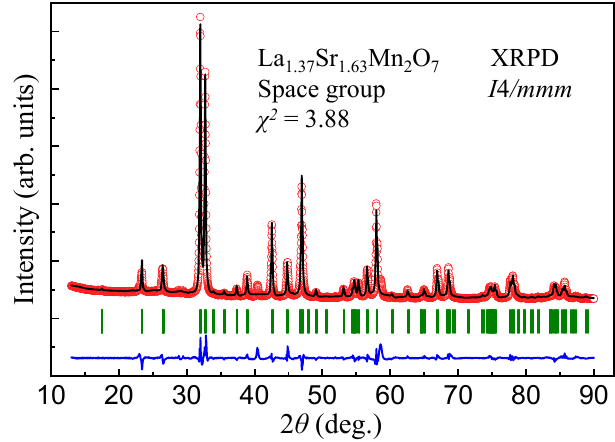
Figure 4. (color online) Observed (circles) and calculated (solid line) room-temperature XRPD patterns collected with a pulverized La 1.37 Sr 1.63 Mn 2 O 7 single crystal at room temperature and refined using FULLPROF SUITE [32]. Vertical bars mark the positions of Bragg peaks. The bottom curve represents the difference between observed and refined XRPD patterns. It is pointed out that the two small extra peaks located at 2 θ = 28.6–29.6 ◦ were attributed to the radiation contamination from the copper K β wavelength. We could not identify the additional peak appearing at 2 θ = 40–40.8 ◦ .